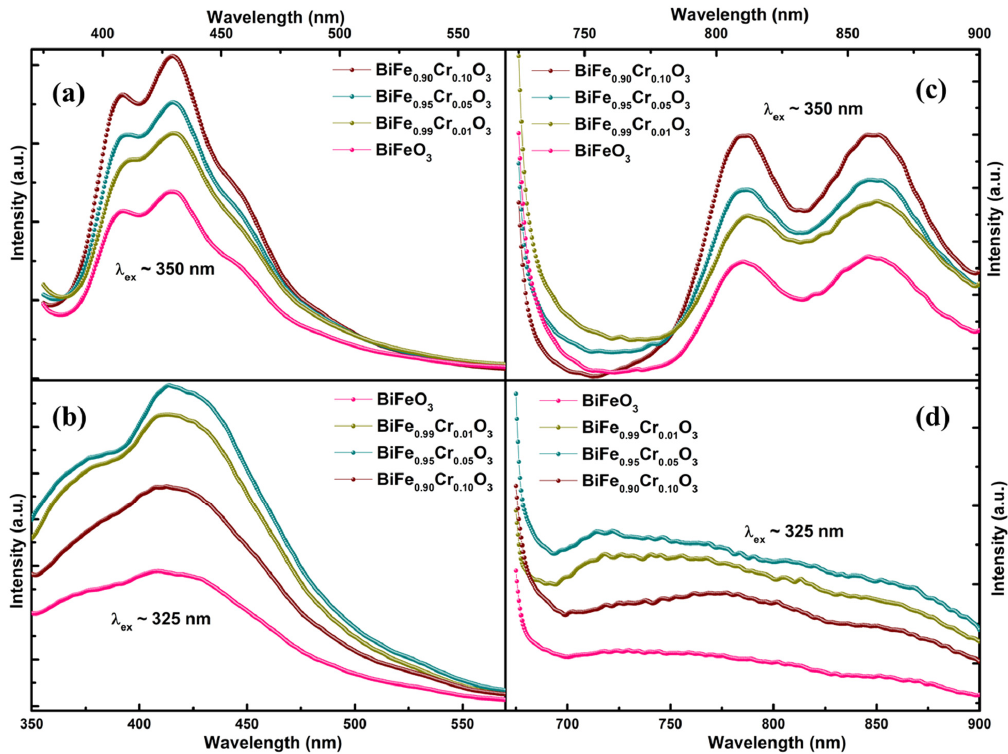
Figure 5. P–L spectra of BiFe 1 − x Cr x O 3 (0 ≤ x ≤ 10) nanoparticles in the ranges ( a , b ) 300–600 nm and ( c , d ) 600–900 nm with the excitation wavelengths of 350 and 325 nm.